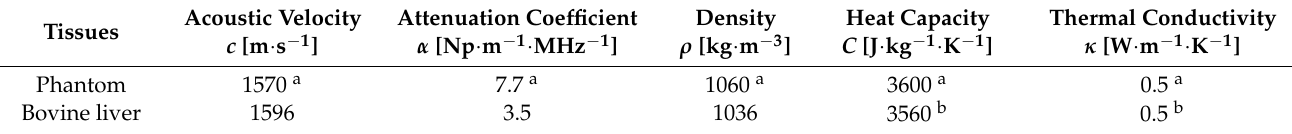
Table 2. Acoustic and thermal parameters of the two